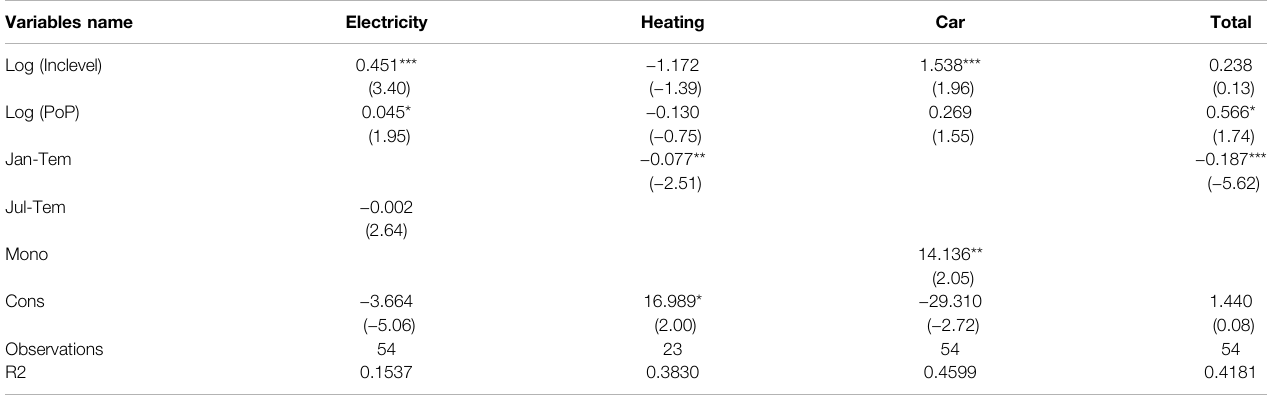
TABLE 5 | Explaining cross city variations in standardized household ’ s carbon emissions.